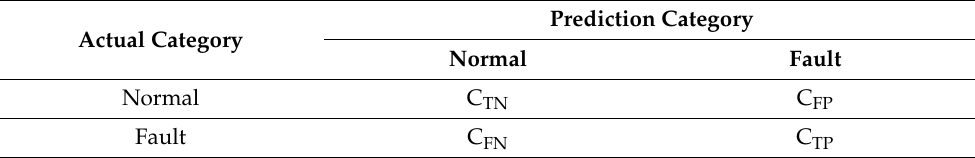
Table 1. Confusion matrix for binary classification